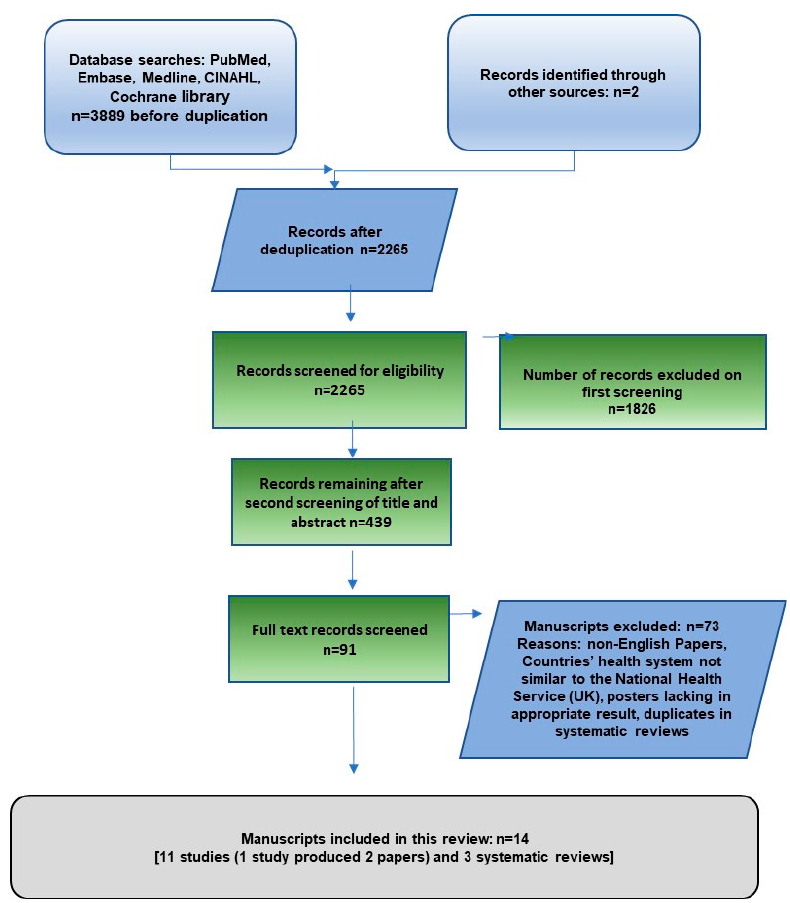
Figure 1. Flow-chart of the identification of included studies and systematic reviews.